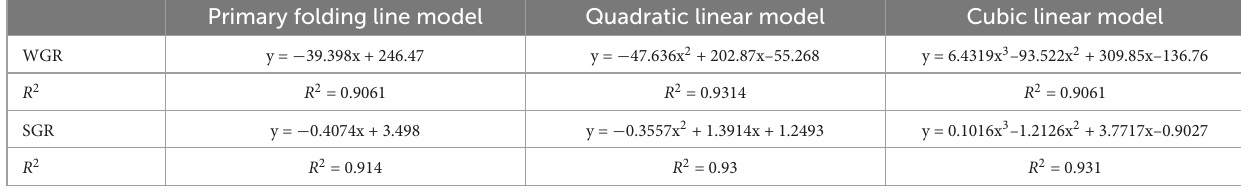
TABLE 5 Linear modeling of the effect of dietary phenylalanine to low fish meal diets on weight gain rate and specific growth rate of triploid O. mykiss